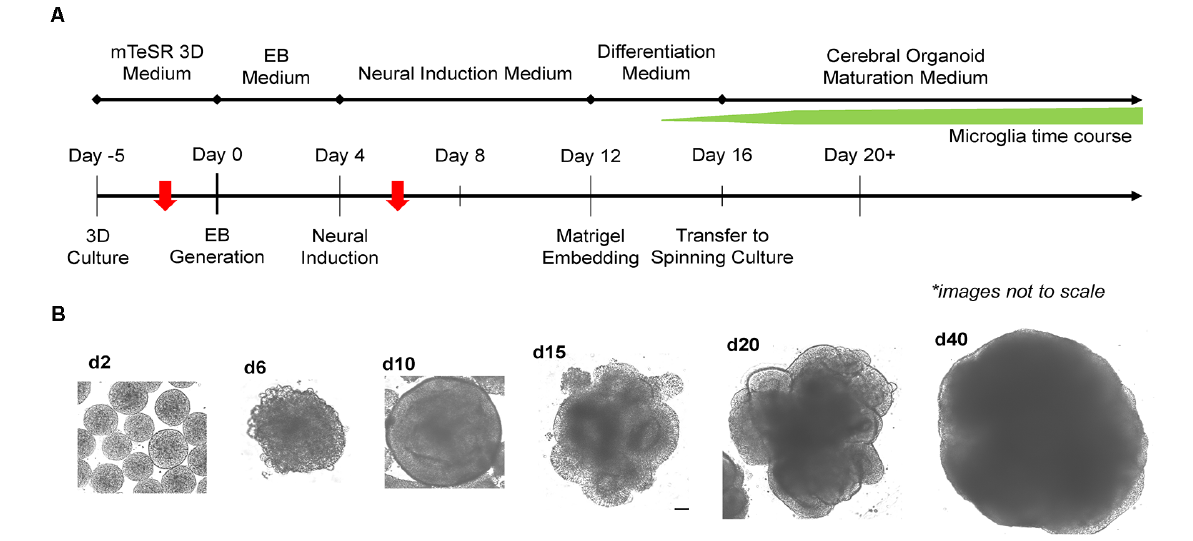
Frontiers in Cellular Neuroscience |